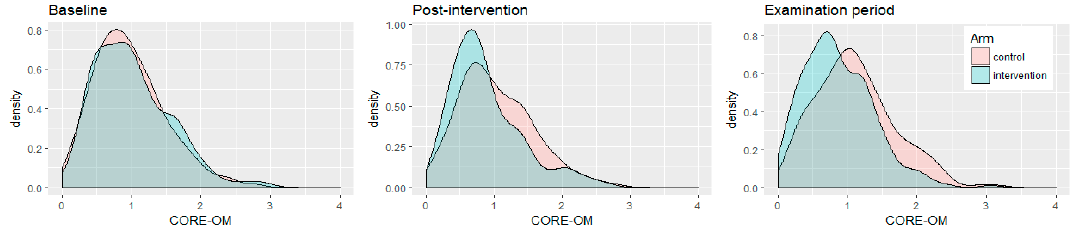
Figure 2. Density plot illustrating the CORE-OM psychological distress scores for each trial arm as students progressed from the moment they signed up for the study (baseline), 2 months later (post-intervention), and during the examination period (4–6 months later). CORE-OM total mean scores range from 0 (no distress) to 4 (maximum distress) (reproduced from Galante 2018 [73] with permission).